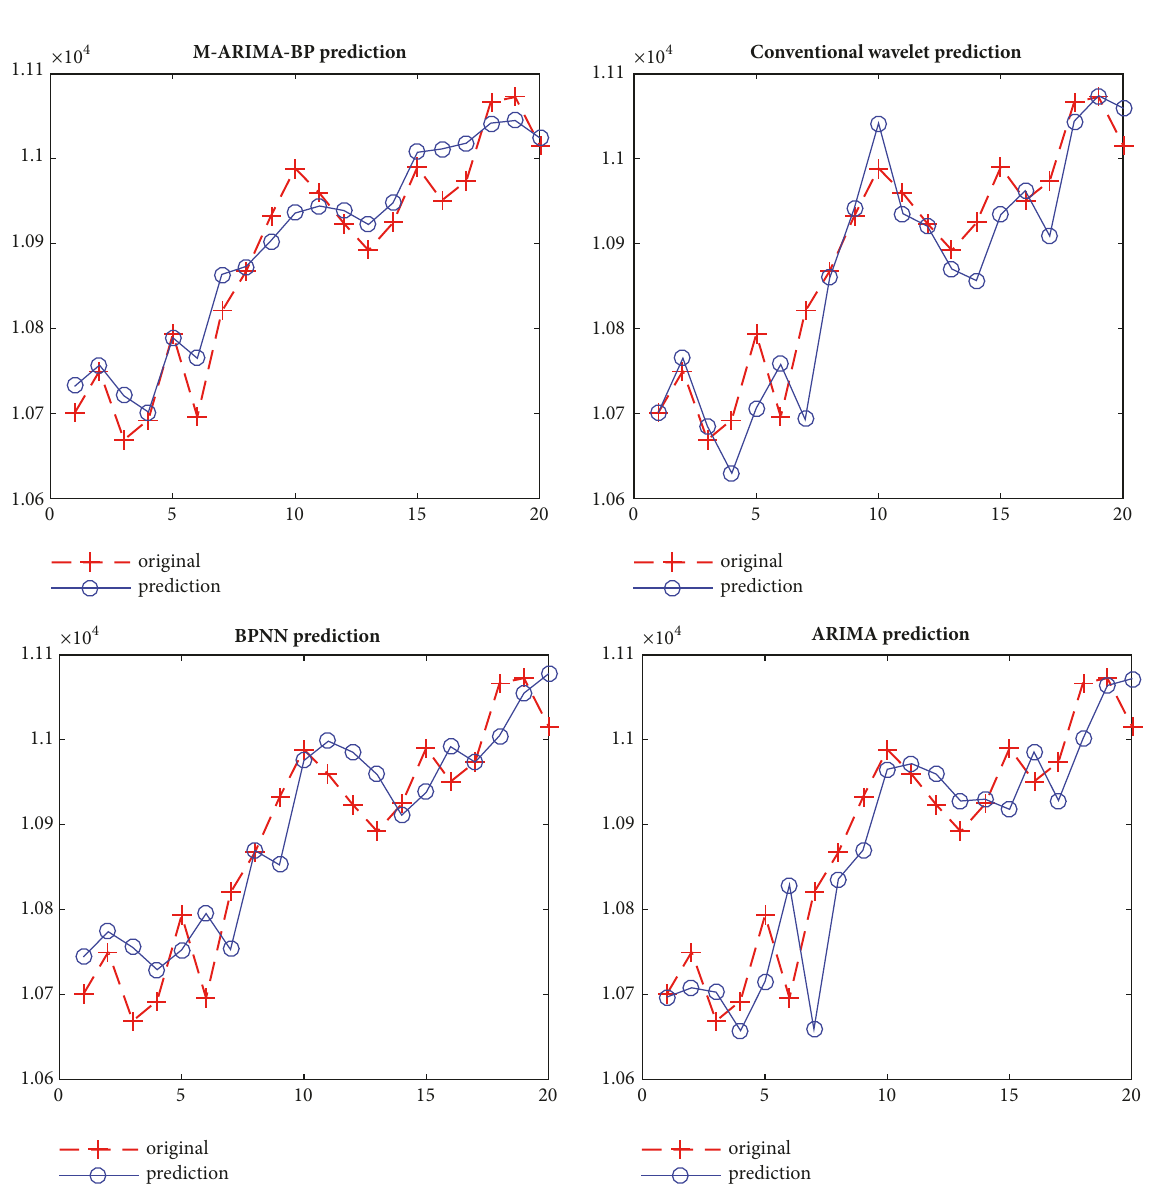
Figure 12: Comparison of the prediction results of Shenzhen Stock Index.